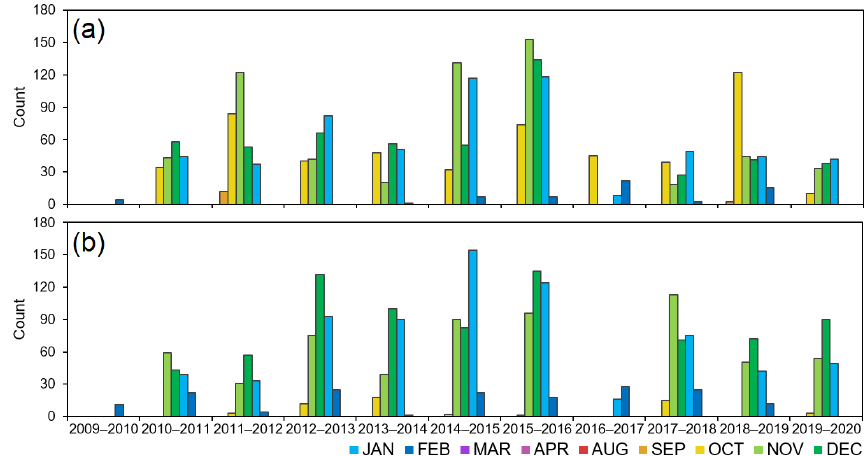
Figure 6. Monthly distribution of the 10% highest UV irradiances at (a) 305nm and (b) 340nm at Marambio Base,